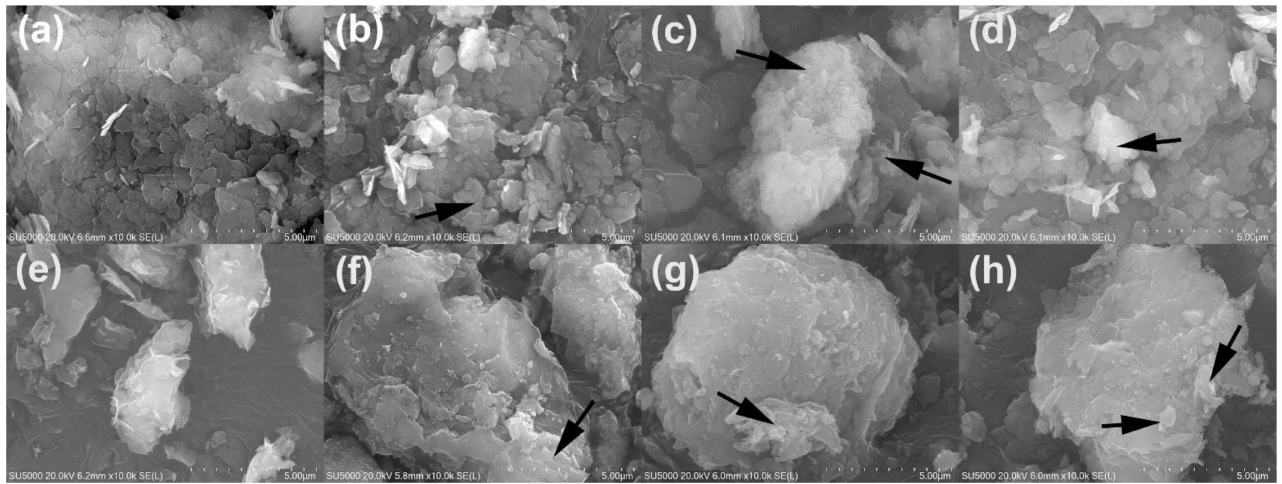
Figure 2. SEM images of ( a ) K, ( b ) CSK42, ( c ) CSK22, ( d ) CSK12, ( e ) MMT, ( f ) CSMMT42, ( g ) CSMMT22, and ( h )